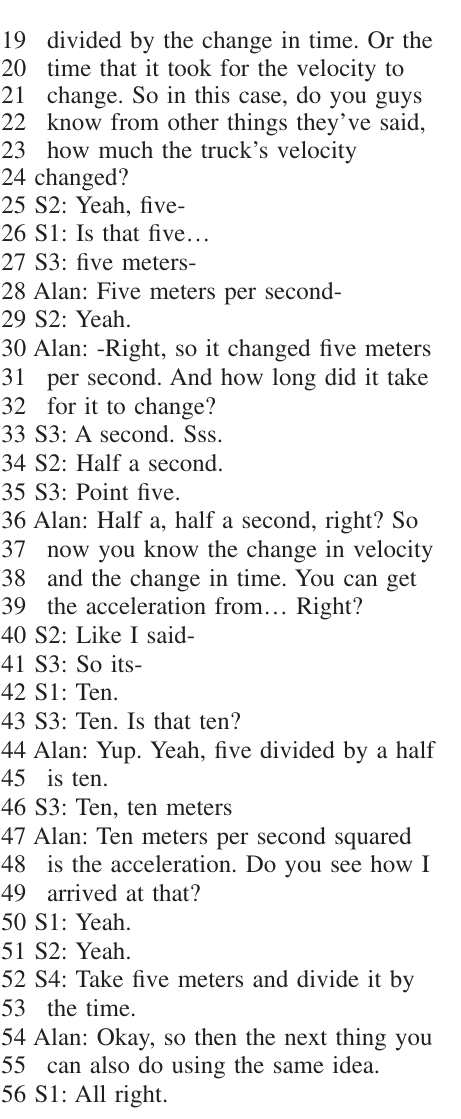
FIG. 2. Two excerpts of the tutorial on Newton’s